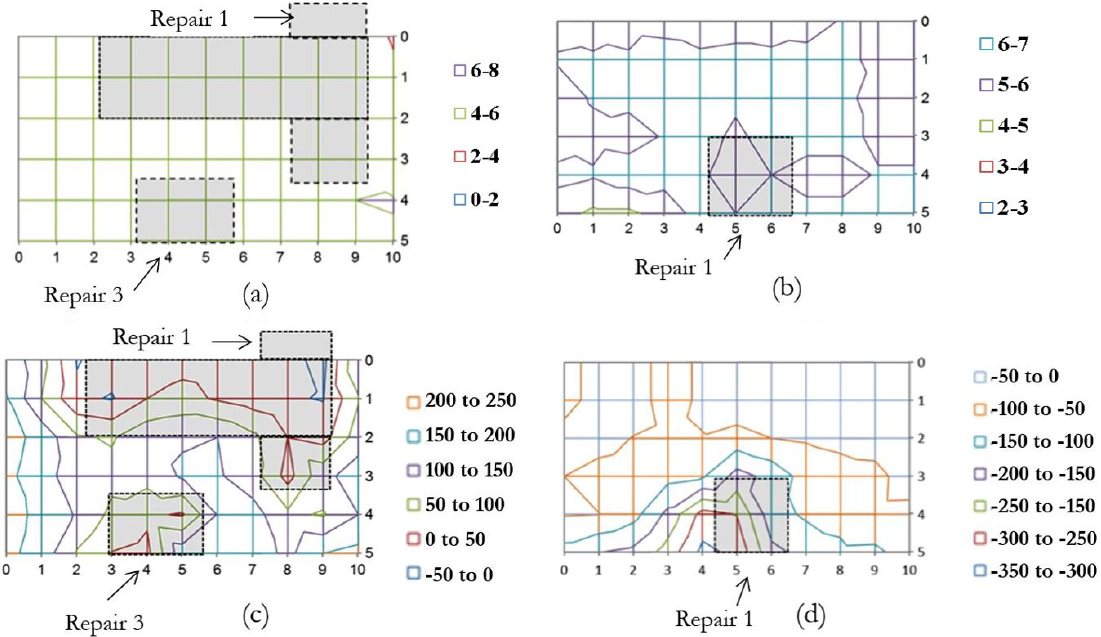
Figure 8. Surface moisture content map (%) in inspected area: (a) on SW façade and (b) on NW façade. Corrosion potential map (EPCP electrode) in inspected area: (c) on SW façade and (d) on NW façade. Corrosion potential values